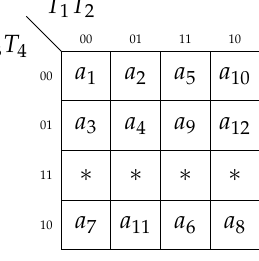
Figure 7. State codes for Mealy FSM U 5 ( S 1 ) . Table 4. DST of Mealy FSM U 5 ( S 1 )